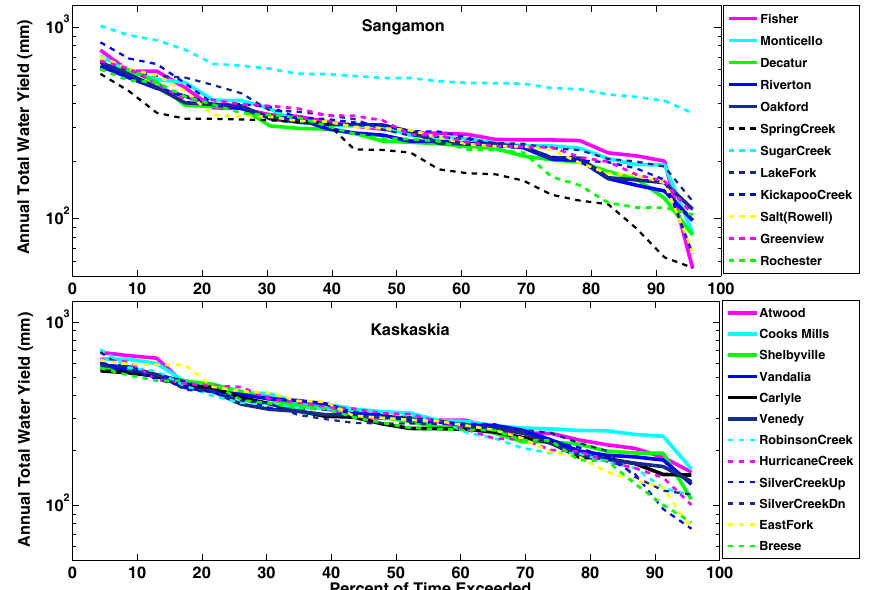
Fig. 6. Streamflow inter-annual variability for both watersheds for 1990–2011. Note that main-stem gauges are shown as solid lines and tributary gauges are shown as dashed lines.